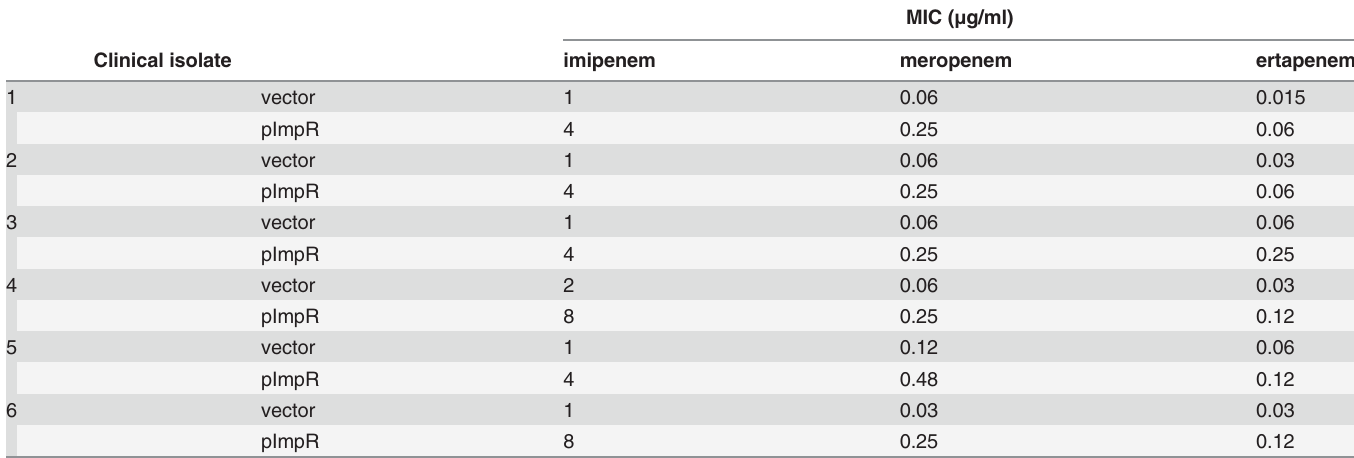
Table 4. MICs of imipenem, meropenem, and ertapenem for P. mirabilis clinical isolates transformed with the ImpR-overexpressing